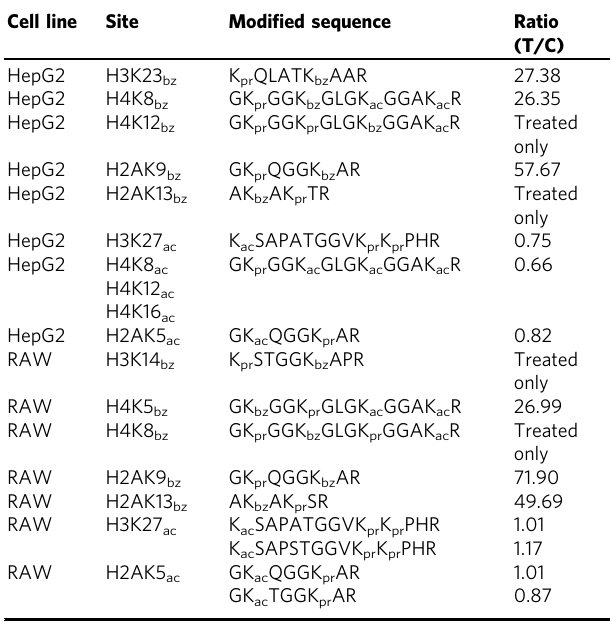
Table 1 Quanti fi ed core histone K bz and K ac site dynamics in response to